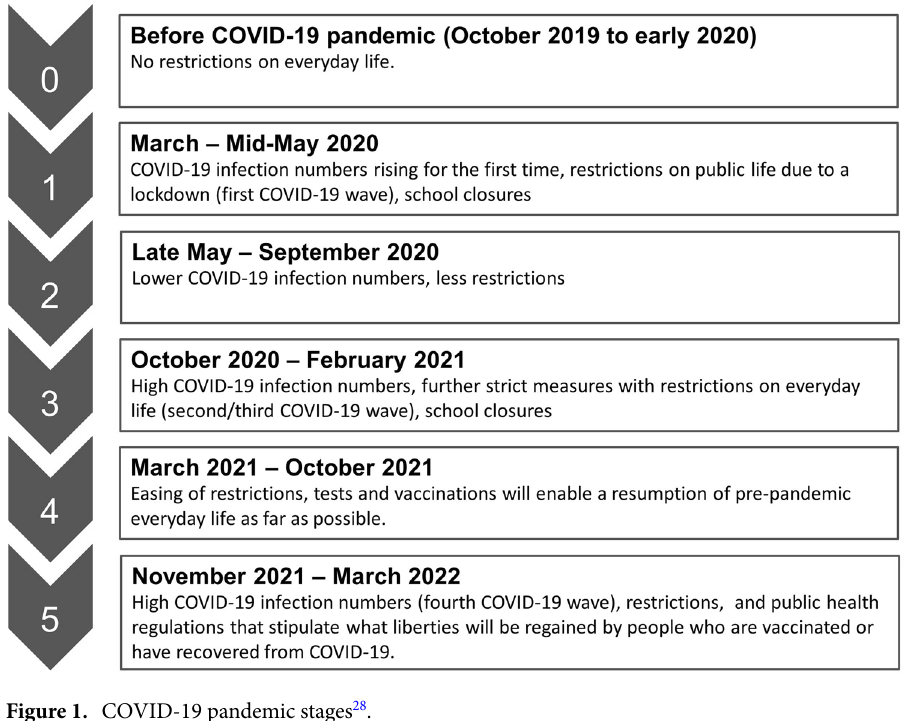
Figure 1. COVID-19 pandemic stages 28